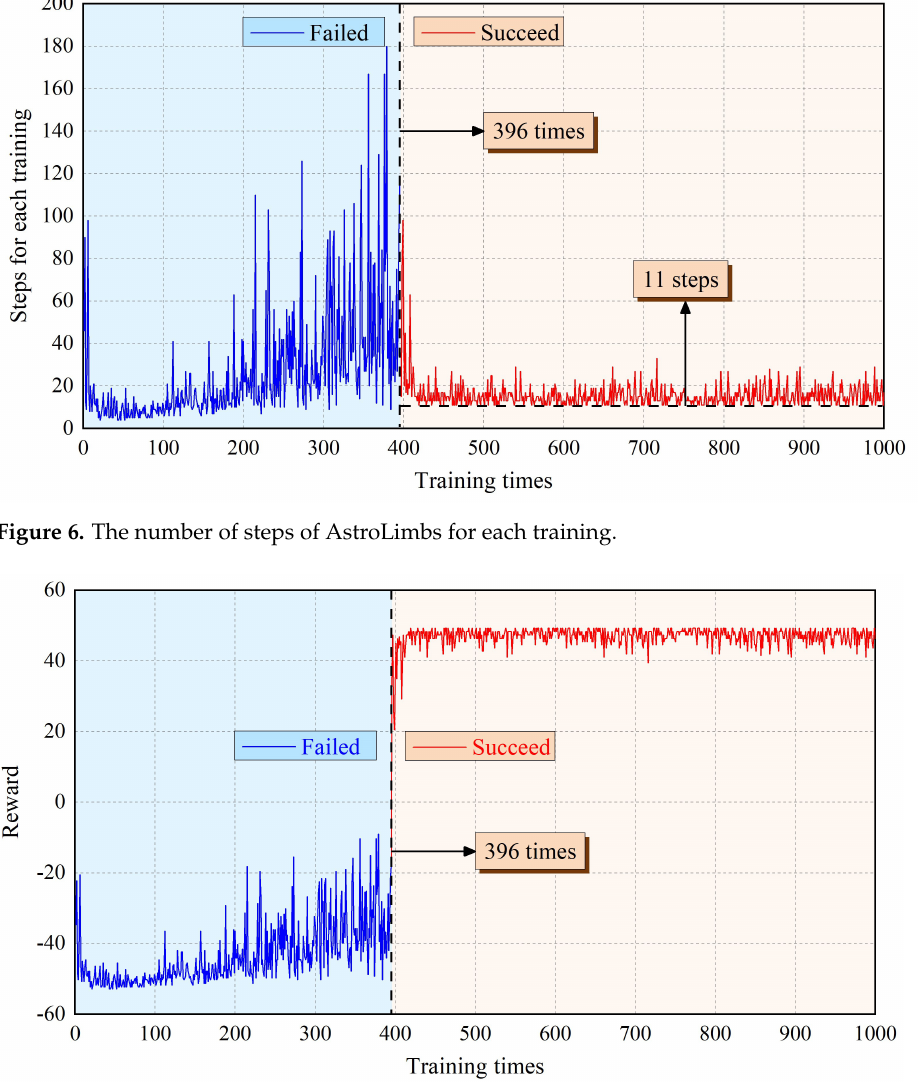
Figure 7. Reward value of AstroLimbs for each